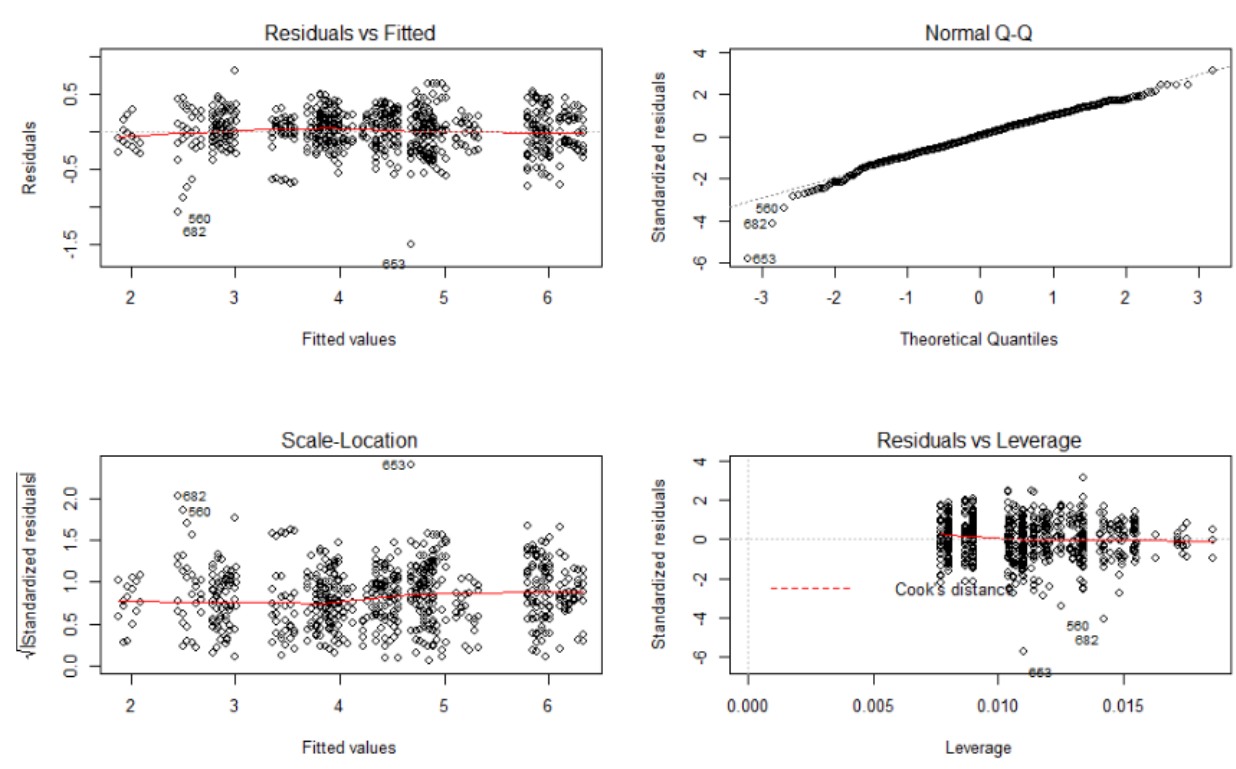
Figure 7. Checking the assumptions for logarithmic regression of the NMF data